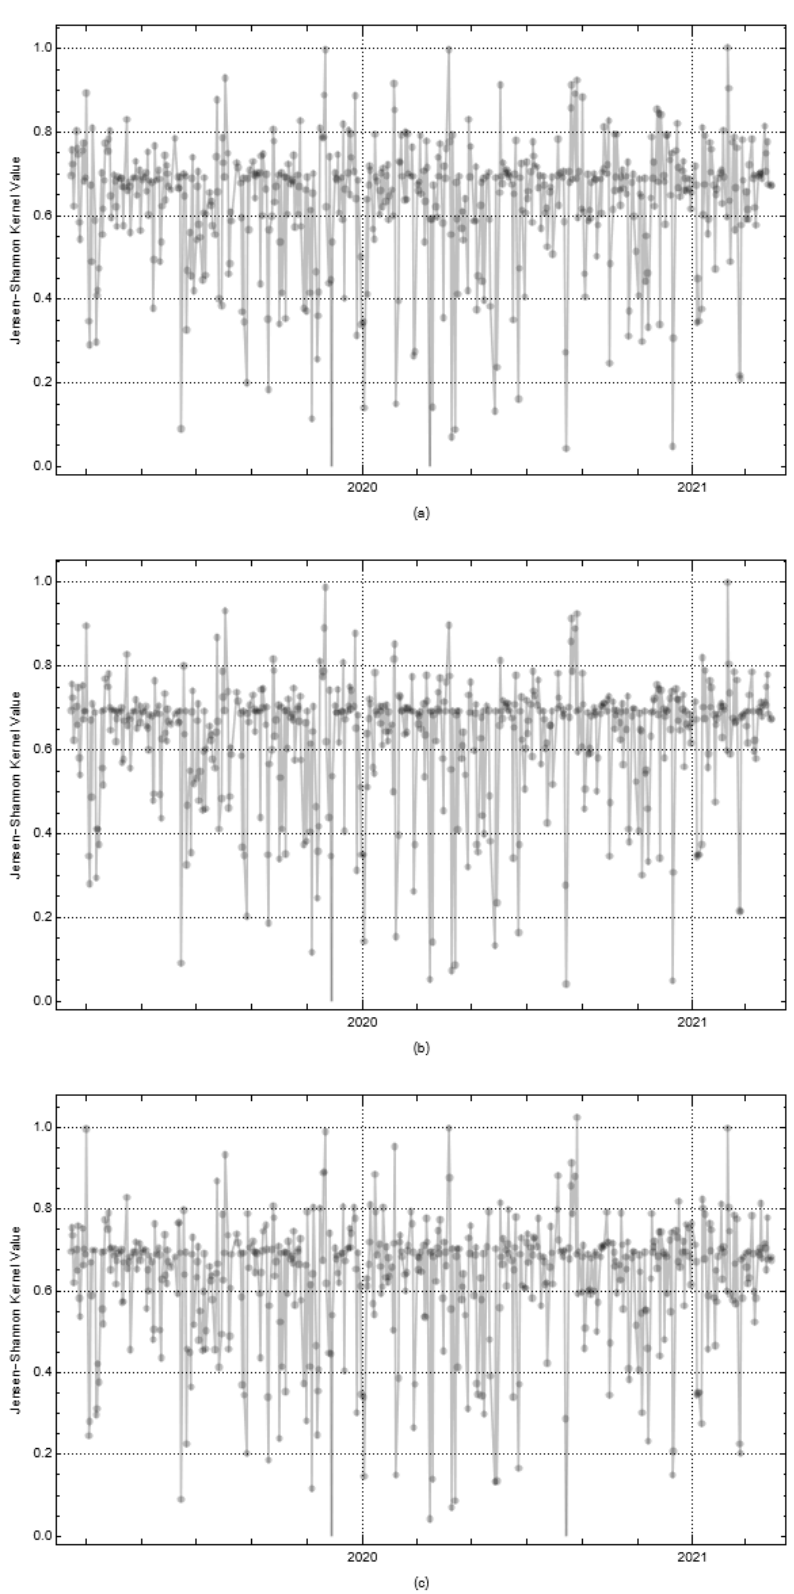
Figure 9. κ JSKS values defined on the emerging network-induced soft sets for the COVID-19 economic Figure 9. 𝜅 (cid:3011)(cid:3020)(cid:3012)(cid:3020) values defined on the emerging network-induced soft sets for the COVID-19 eco- nomic period: ( a ) weekly, ( b ) biweekly, ( c ) triweekly. period: ( a ) weekly, ( b ) biweekly, ( c )